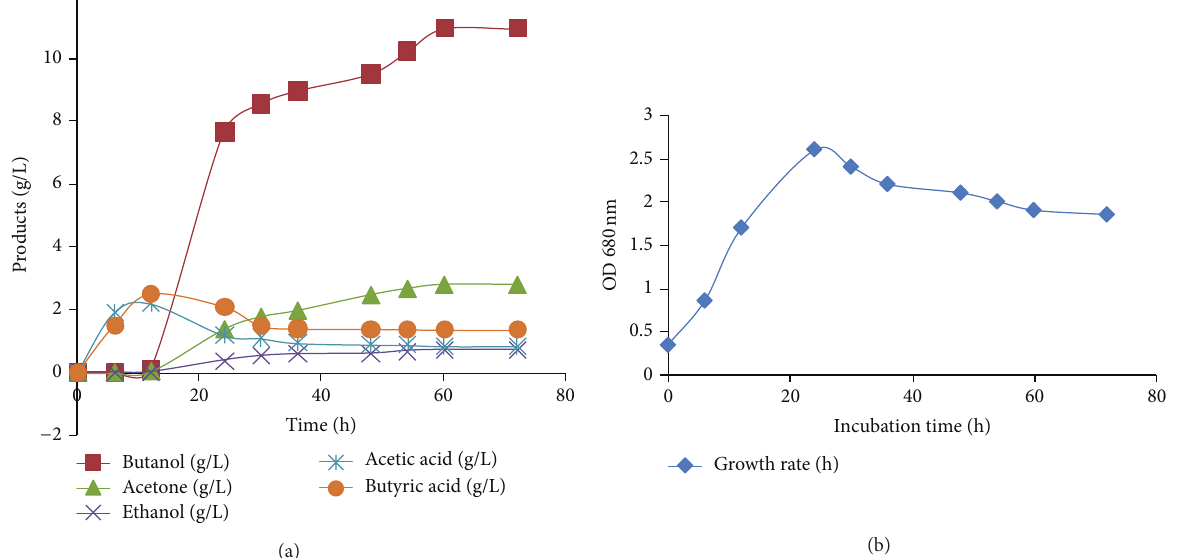
Figure 2: Production of ABE from date fruit by C. acetobutylicum NCIMB13357: (a) products at various fermentation times and (b) fermentation time and microbial growth curve based on optical density values (OD) at 680